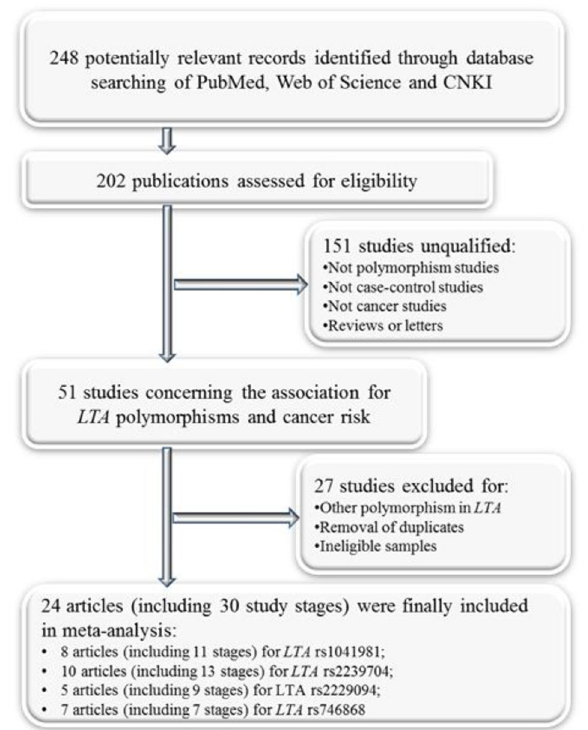
Figure 1. Flow diagram depicts literature search and study